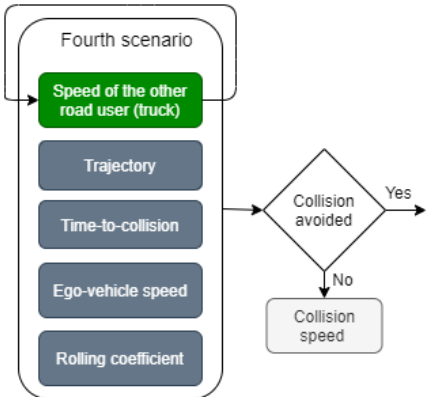
Figure 18. Parameters used in the sensitivity analysis in the fourth